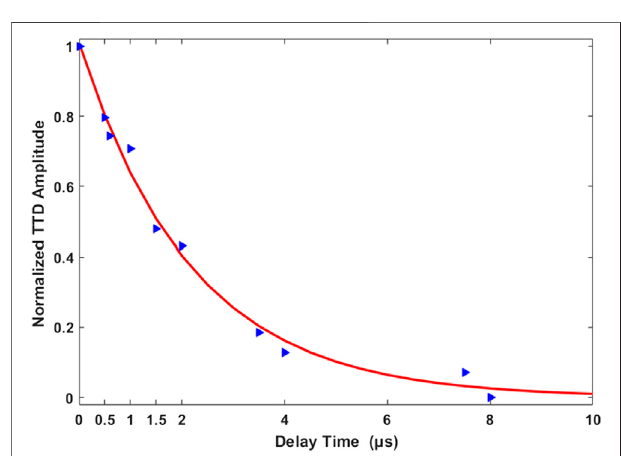
FIGURE 6 | Normalized TTD signals with varying delay